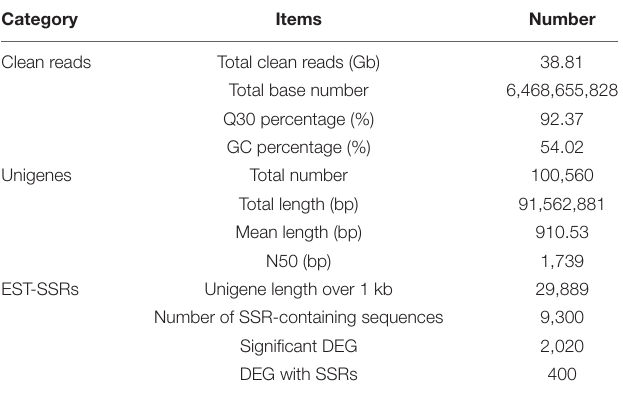
TABLE 2 | Summary of the analysis of de novo assembled EST-SSRs in Psathyrostachys juncea .